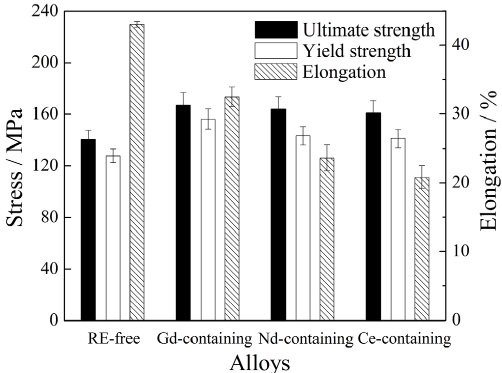
Figure 5. Mechanical properties of as-extruded RE-free and RE-containing